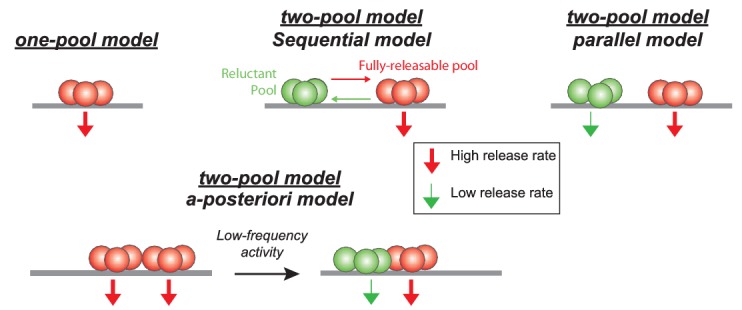
Schematics showing different models of SV release at GC-PC synapses.Based on hypothesis proposed in other synapses, presynaptic release could be mediated by a homogeneous pool of release-ready SVs (one-pool model) or through a two-pool model with alternative stages of transition between the two pools. For the two-pool model, releasable SVs are separated in a fully-releasable pool (red SVs) or a reluctant one (green SVs).